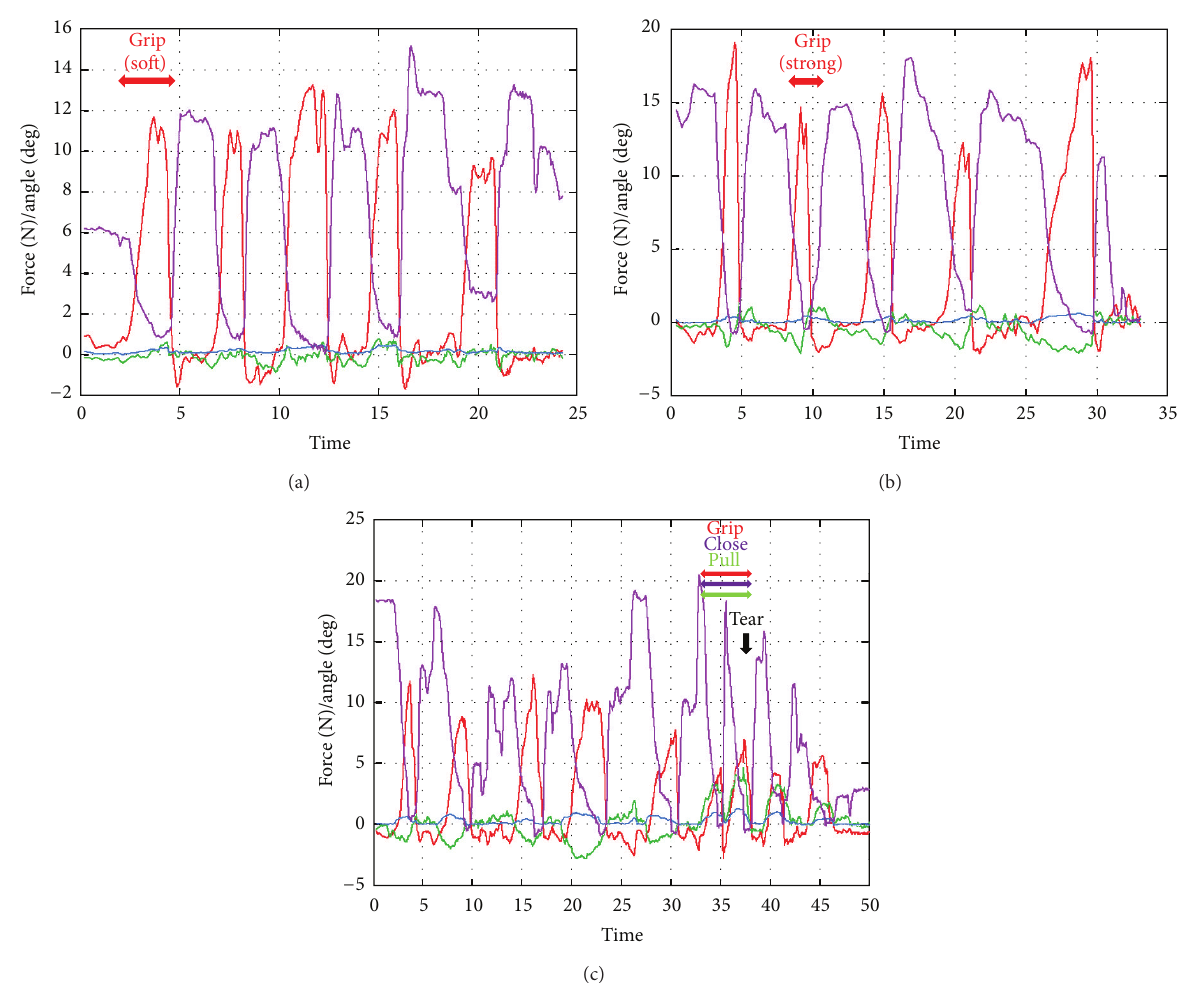
Figure 12: Experiment (I), grip the kidney softly; (J) grip the kidney strongly; (K) grip and pull on the kidney.